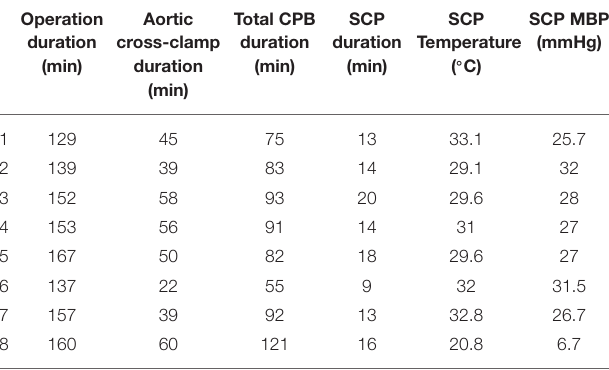
Frontiers in Medicine |